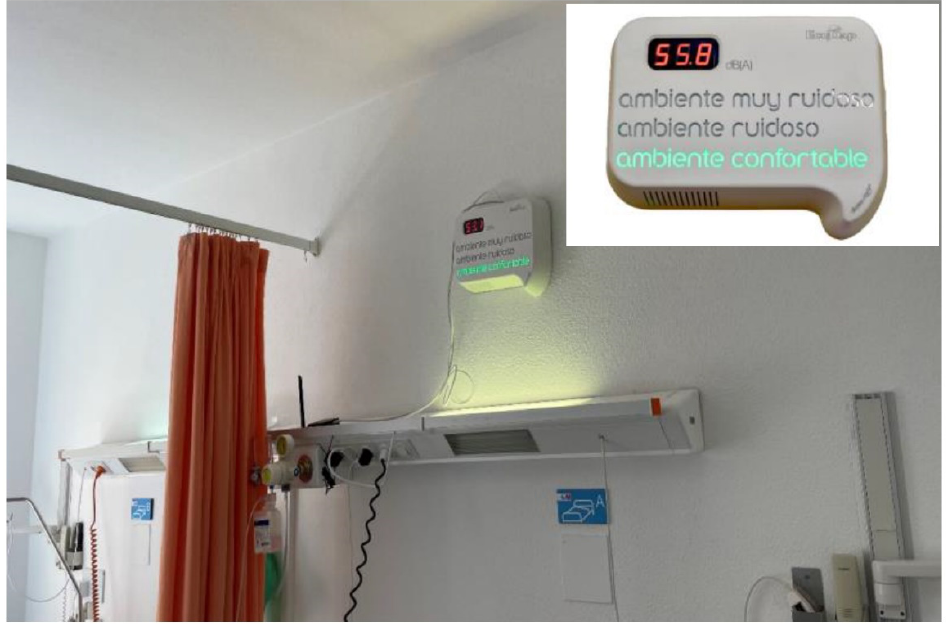
Figure 2. Monitoring system, SAS 2000, in a typical ICU.